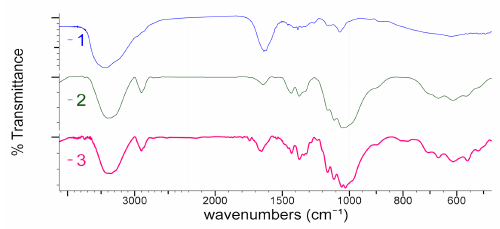
Figure 4. FTIR spectra for D-CD compound ( 1 ), control sample ( 2 ), treated sample (S15 as spectrum 3